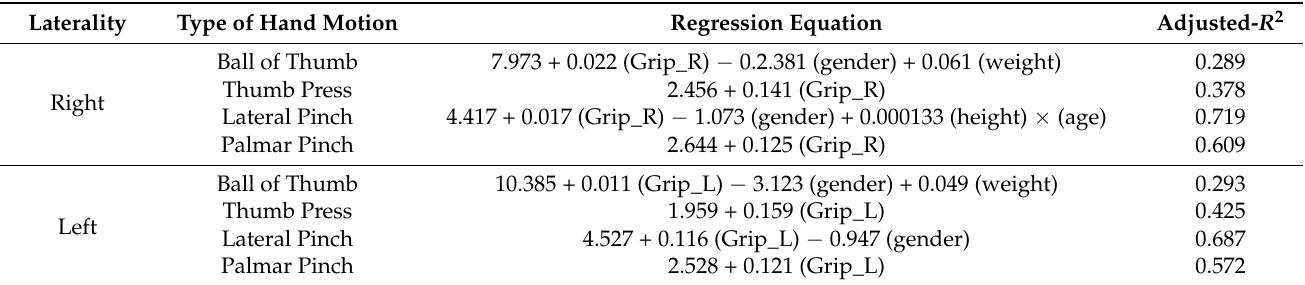
Table 5. The prediction models using measured grip strength, demographic variables, and interaction of demographic variables by